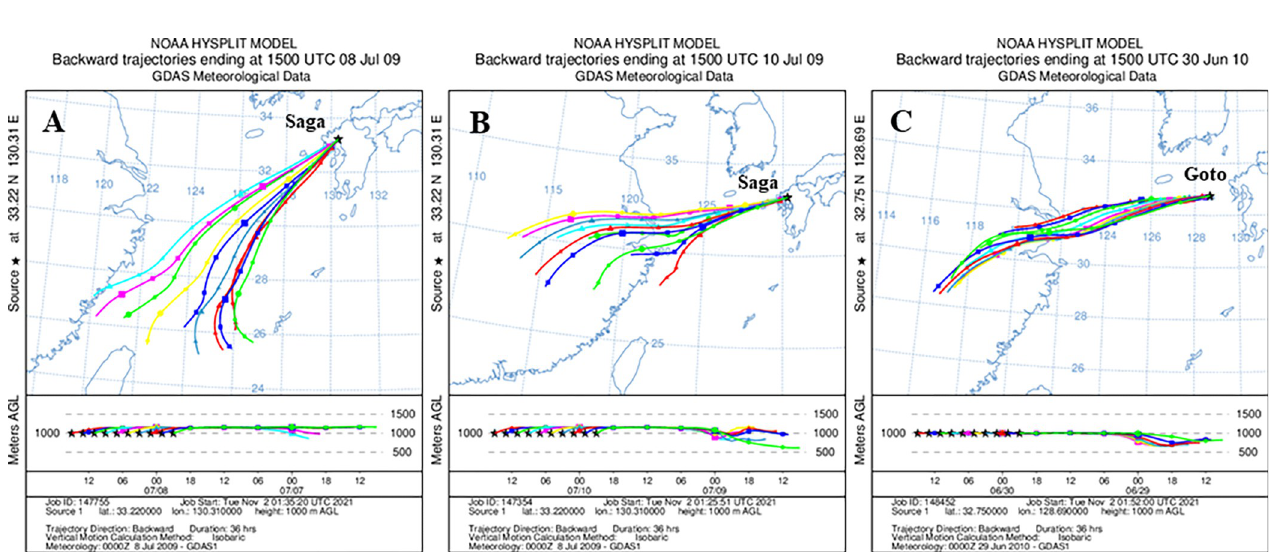
Fig 8. Computed back trajectories at 2-h intervals for the 36-h period ending at 1500 UTC of 8 and 10 July 2009 at Saga City (A and B), and 30 June 2010 at Goto City (C). Top portion shows the horizontal path, and the bottom portion shows the vertical path of the trajectories. Each figure is the result of a backward trajectory analysis of HYSPLIT using the NOAA website: https://www.ready.noaa.gov/HYSPLIT.php.